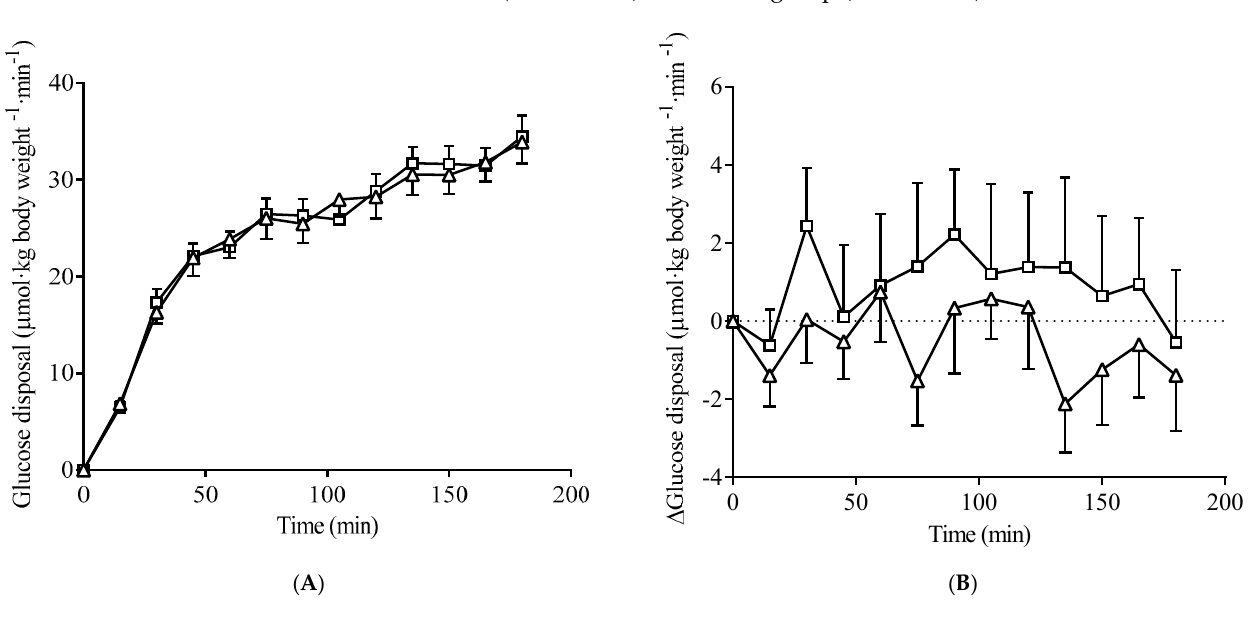
Figure 1. ( A ) Glucose disposal rate during the pre-intervention hyperinsulinemic clamp and ( B ) change in glucose disposal rate after the intervention (measured during the clamp), for the high-flavanol cocoa ( □ ) and low-flavanol cocoa ( Δ ) groups ( n = 16 in each group). Data are the mean, with error bars indicating SEM. Table 2. Measures made pre- (PRE) and post-intervention (POST) in those consuming high-flavanol (HFC) or low-flavanol (LFC)